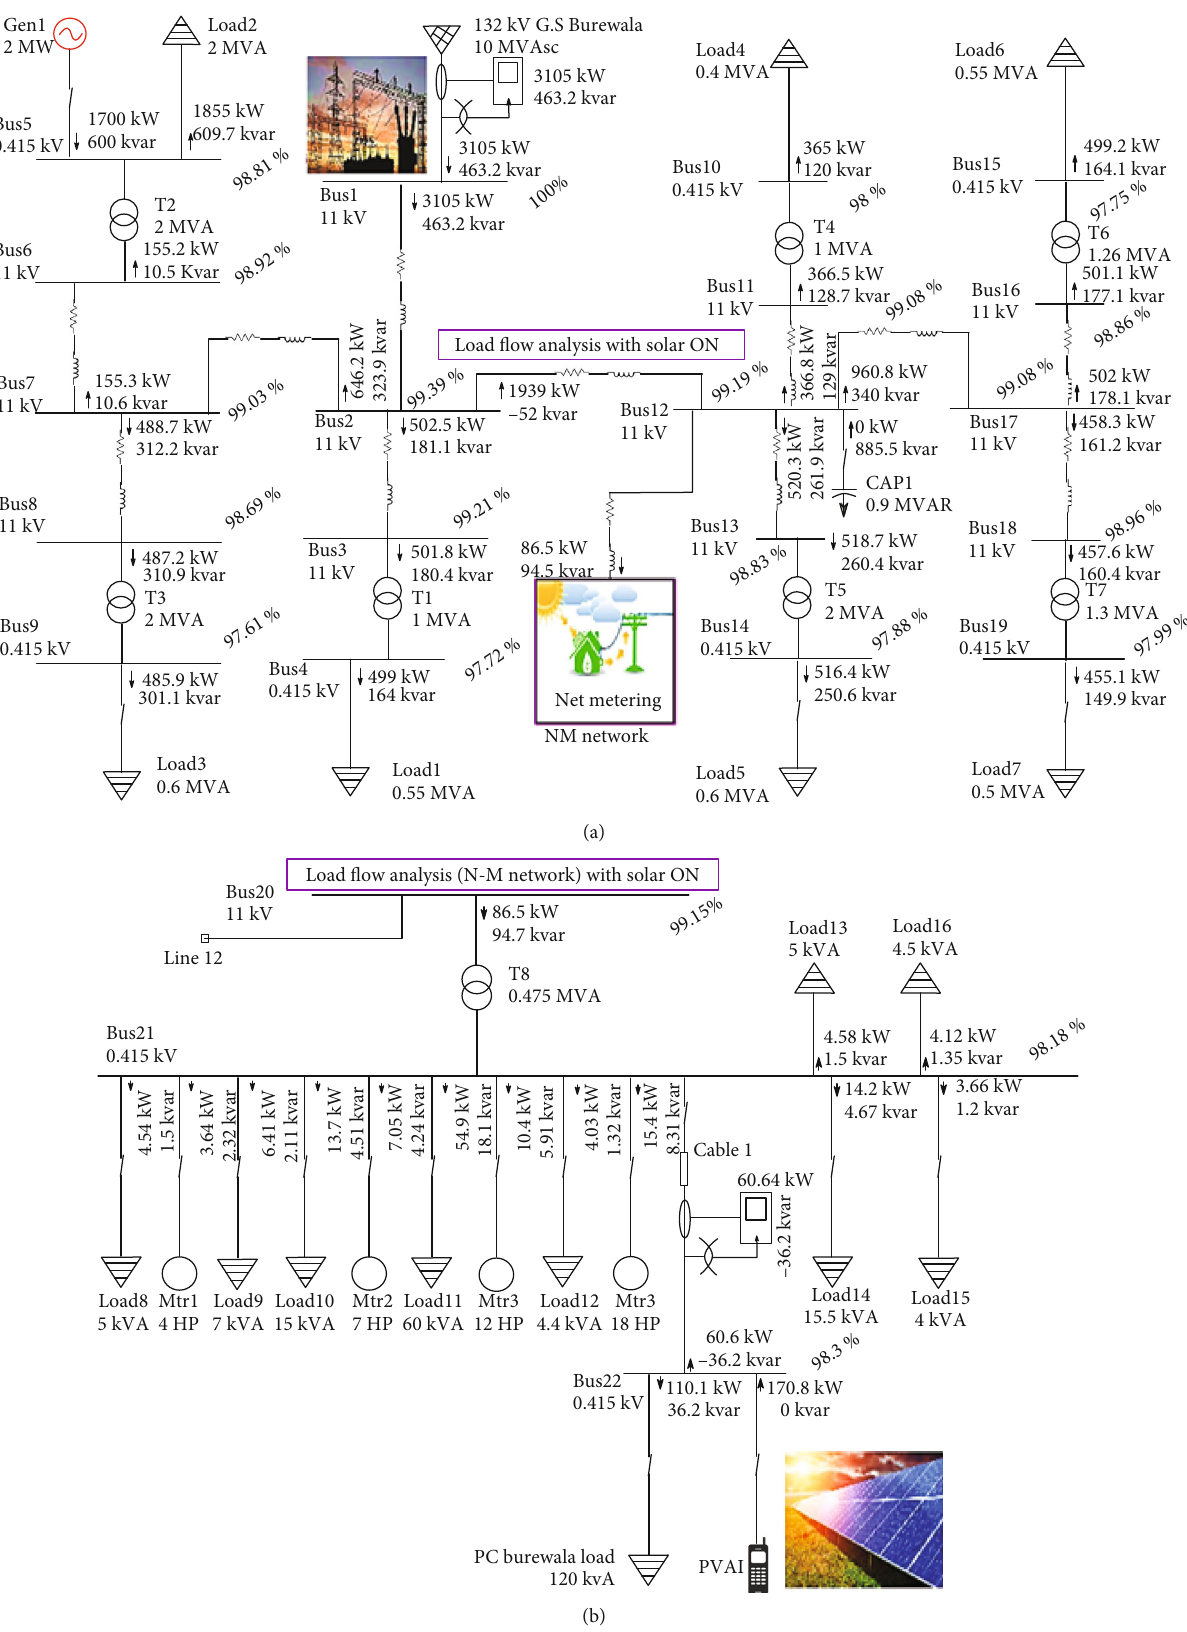
Figure 4: (a) Load fl ow analysis with Bus22 load ON/solar ON. (b) Load fl ow analysis (N-M network) with Bus22 load ON/solar